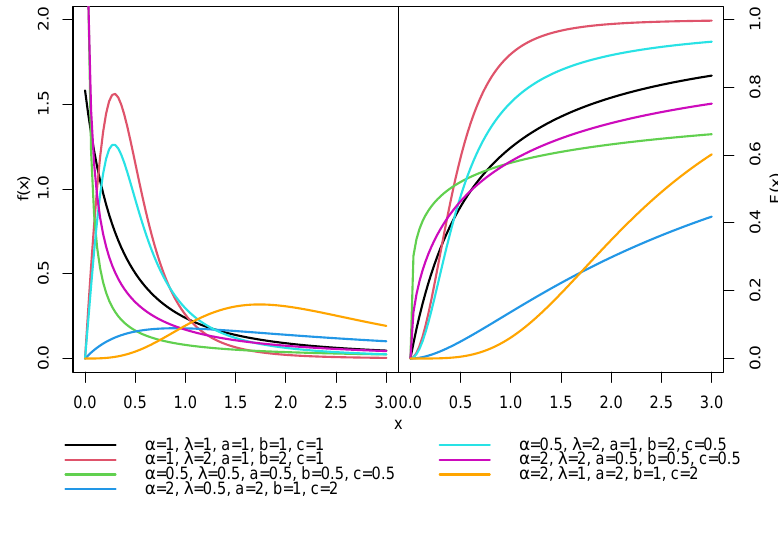
Figure 5 – PDF (left panel) and CDF (right panel) of McLLP